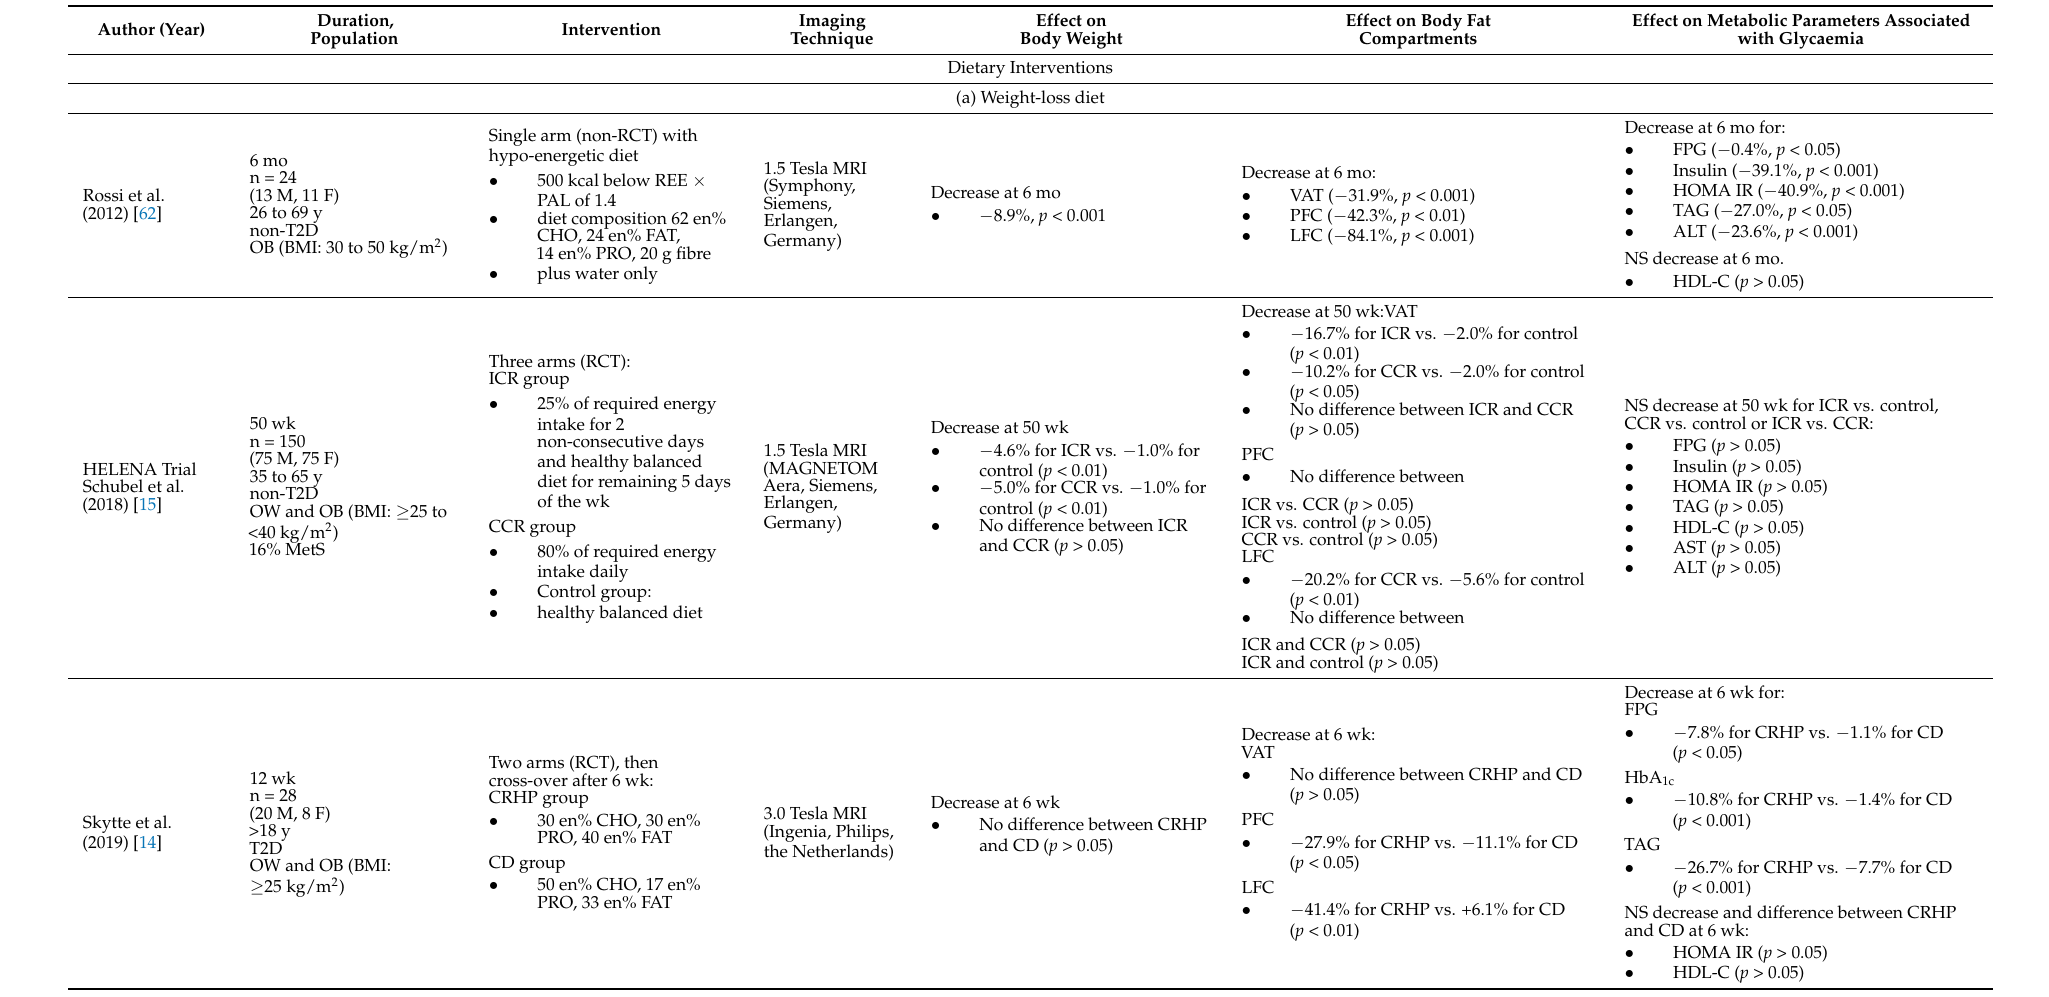
Table 2. Various lifestyle and surgical trials reporting effects on pancreas fat and other key parameters related to metabolic